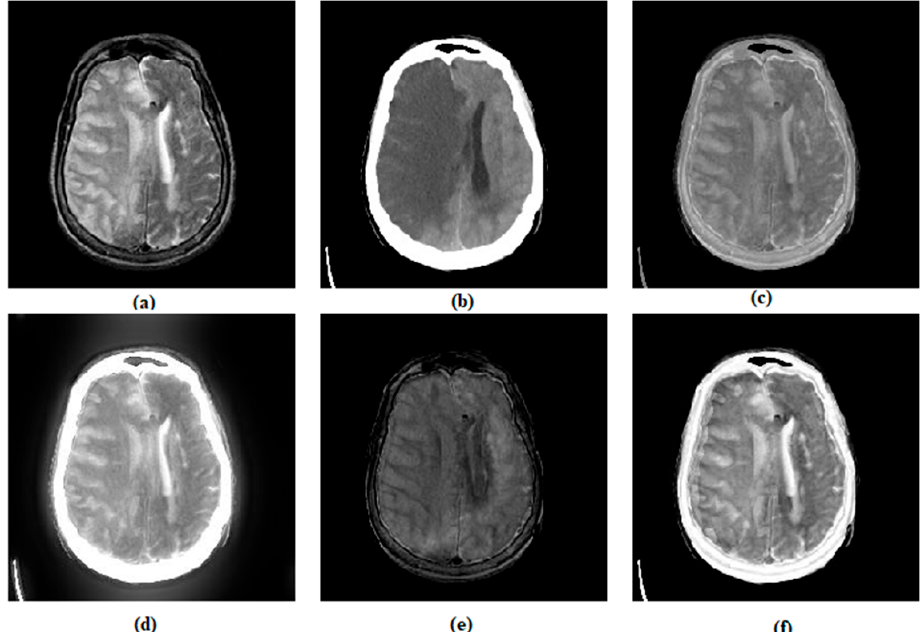
Figure 4. Visual quality analysis of various fusion rules on MRI-CT image pair. ( a ) MRI image, ( b ) CT image, ( c ) VMD-AVG, ( d ) VMD-MAX, ( e ) VMD-MIN ( f ) VMD-LEM. Table 2. Average quantitative analysis of various fusion rules on 10 pairs of MRI-CT images. Metrics